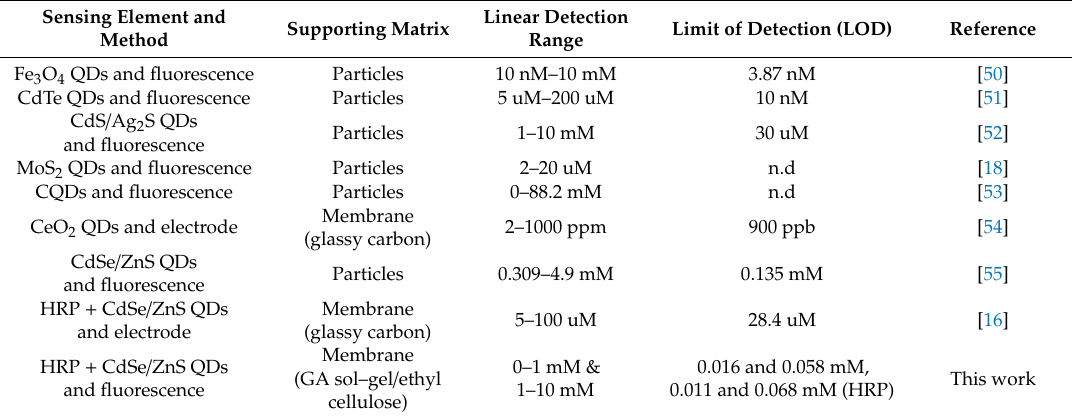
Table 1. Comparative study of H 2 O 2 sensors using quantum dots (QDs).